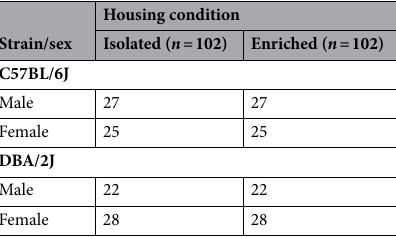
Table 1. Sample size of experimental groups. Each isolation-housed mouse was matched to an enrichment- housed littermate that was housed on the same shelf side-by-side and tested in the same behavioral apparatus.